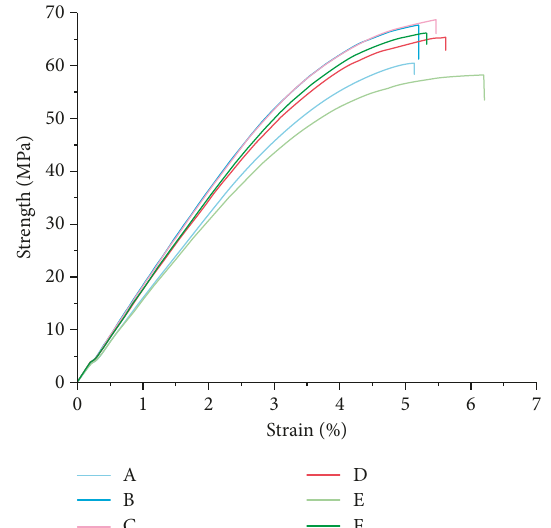
Figure 2: Strength-strain curves of resins having different values.